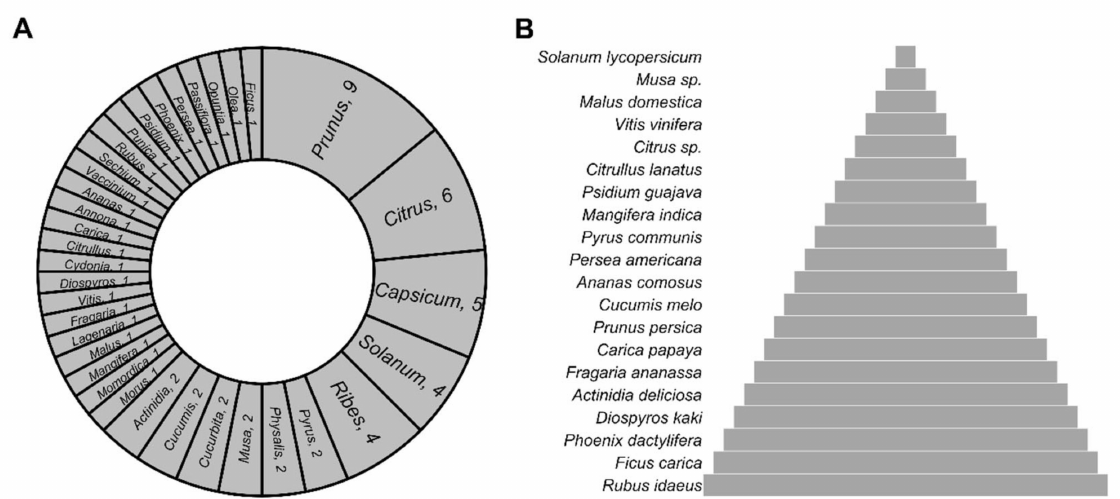
Figure 2. Commercially important EFFs. ( A ) Genera in which the 64 EFFs with a prominent role in the global market belong. The number of species in each genus is indicated. ( B ) The top 20 most important EFFs are shown as a pyramid, which is divided into layers. The top layer represents the most traded EFF and the bottom layer the less traded, respectively.